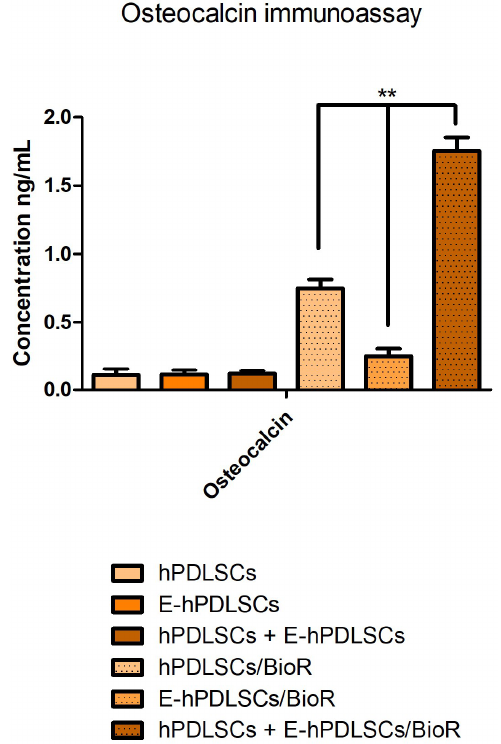
Figure 8. Osteocalcin immunoassay. Graph showed the osteocalcin level measured in supernatant after two weeks of culture in hPDLSCs, E-hPDLSCs and hPDLSCs + E-hPDLSCs cultured with and without BioR. Experiments were performed in triplicate. ** p < 0.01.